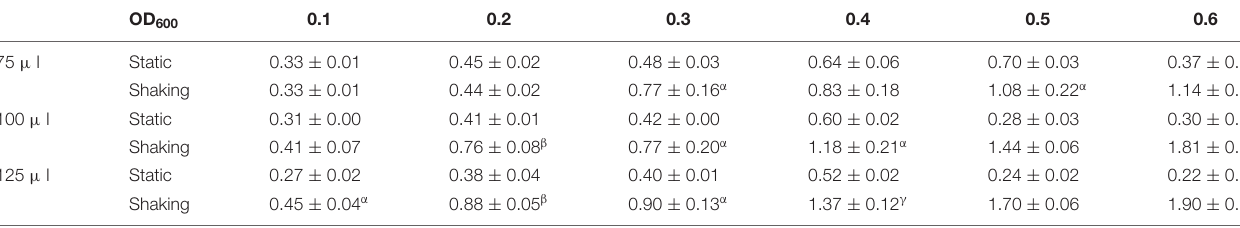
TABLE 2 | Comparison of SBFs under static and shaking